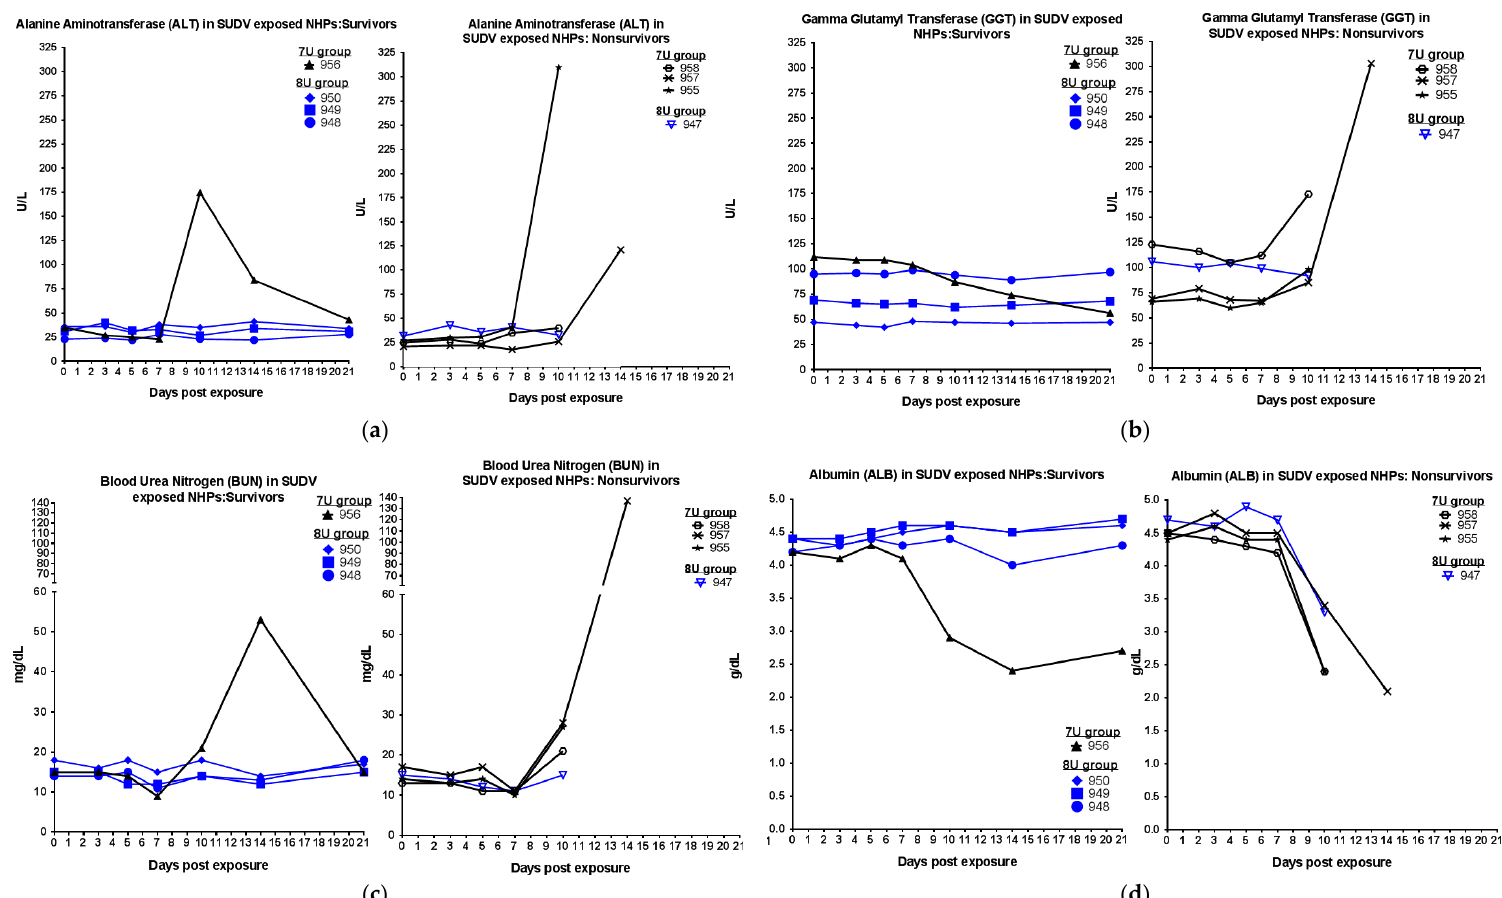
Figure 5. Clinical chemistry parameters in Macaca fascicularis exposed to low doses of Sudan virus (SUDV). M. fascicularis were experimentally exposed to 0.01 plaque-forming units of SUDV with either 7-uridine (7U) or 8-uridine (8U) genotypes. During each scheduled sedation, and when possible at the time of death, blood specimens were collected and analyzed. Results of clinical chemistry analysis for all SUDV-exposed animals throughout the course of the study are shown. NHPs—nonhuman primates. ( a ) Alanine aminotransferase (ALT) in SUDV-exposed NHPs. ( b ) γ glutamyl transferase (GGT) in SUDV-exposed NHPs. ( c ) Blood urea nitrogen (BUN) in SUDV-exposed NHPs. ( d ) Albumin (ALB) in SUDV-exposed NHPs.